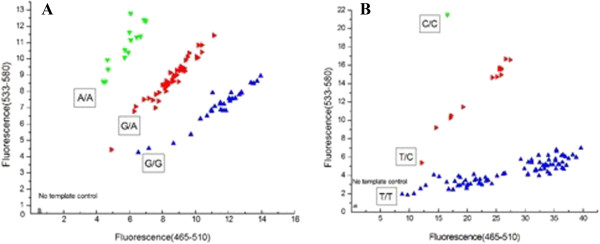
Real-time PCR genotyping of rs2735839 (A) and rs731236 (B).